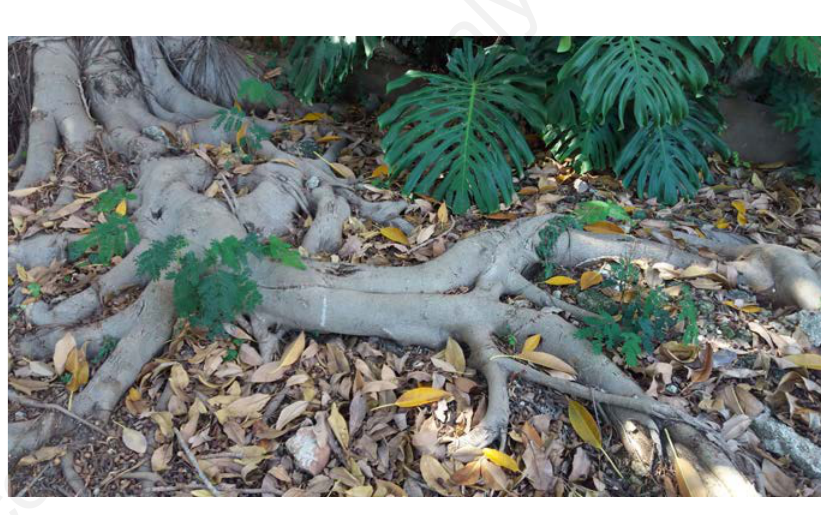
Figure 2. Leucaena saplings growing under the shady canopy of Ficus macrophylla f. columnaris at the Campus of SAAF Department (University of Palermo). Please remark